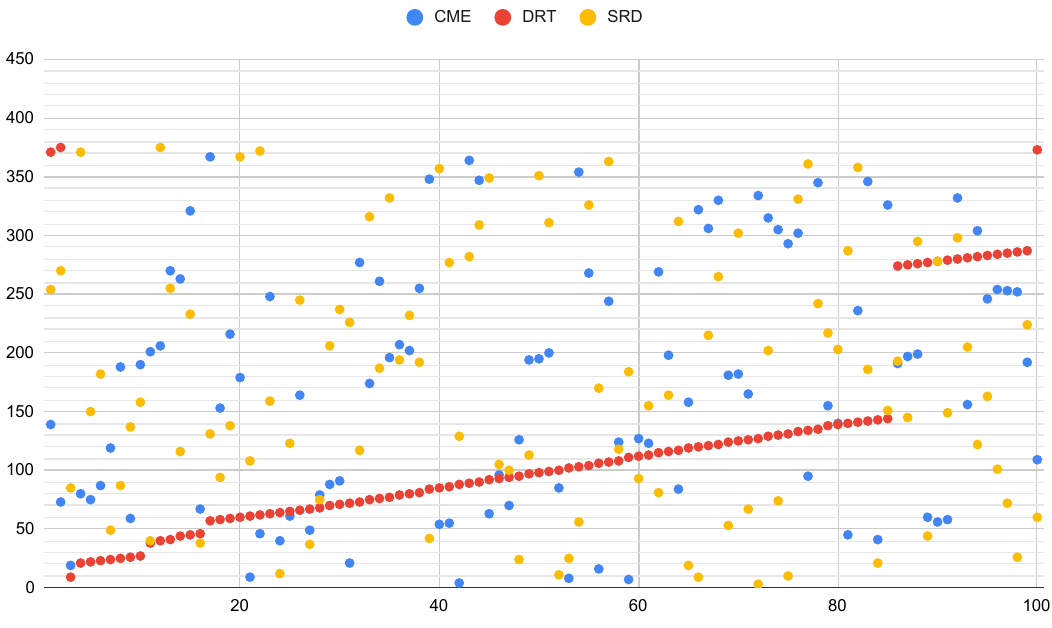
Figure 10. Top 100 features that were selected for each of the considered DME types.